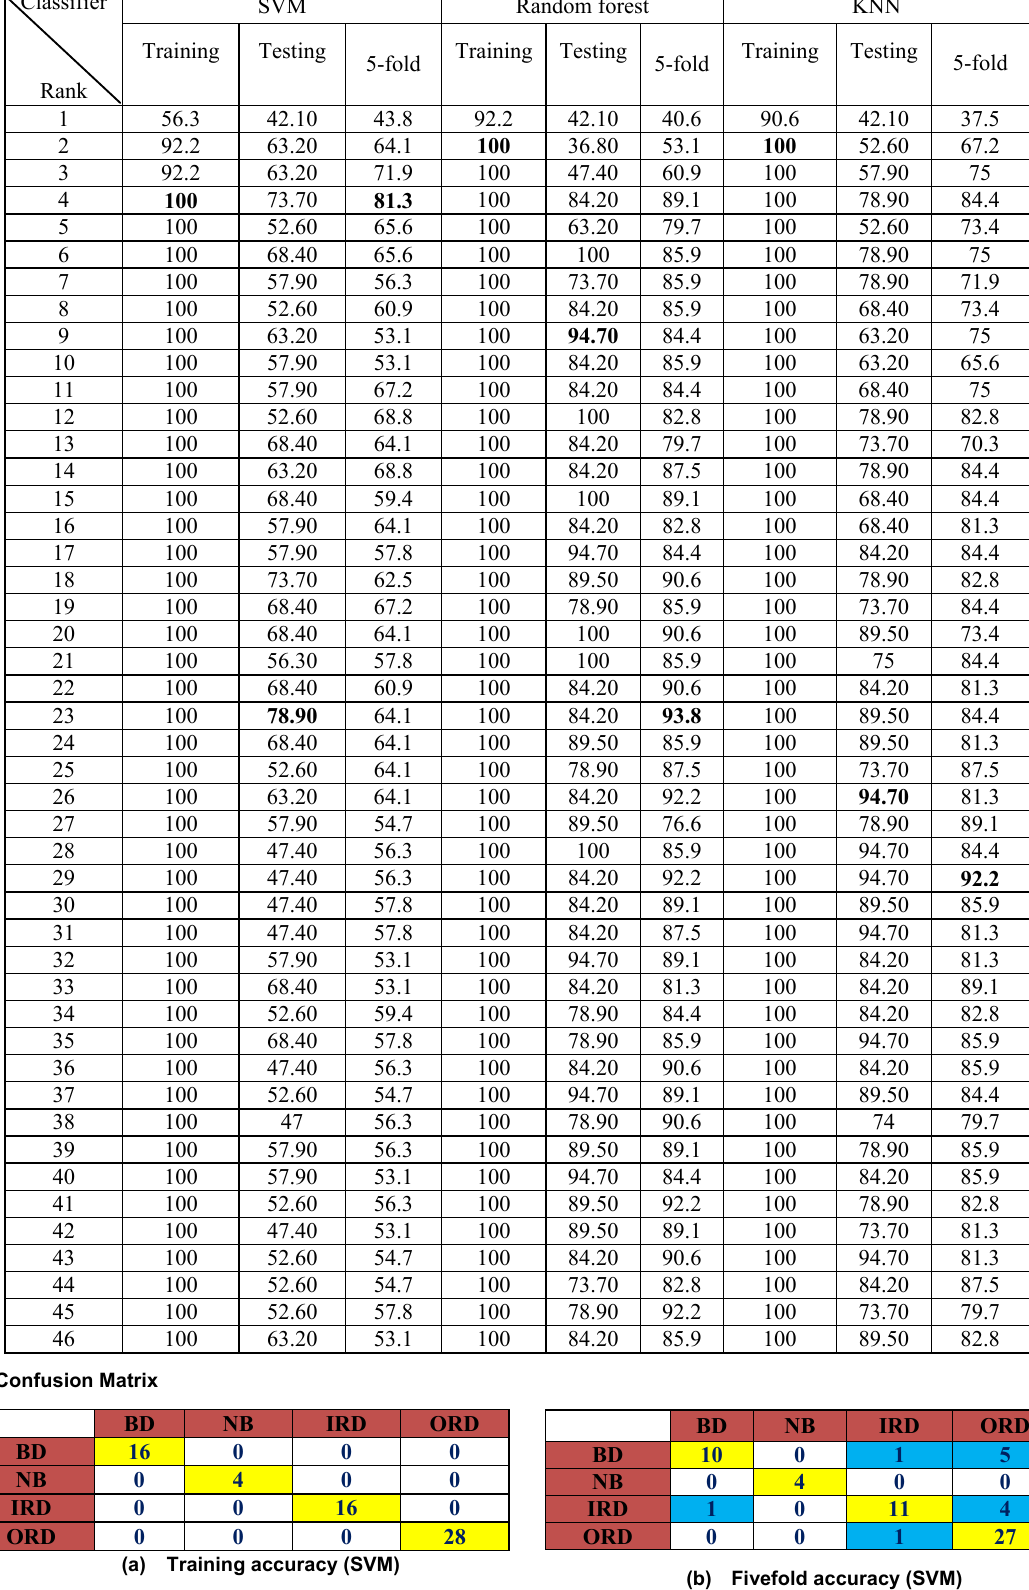
Table 3. Training, Testing, and 5-Fold Cross Validation Accuracies Classifier